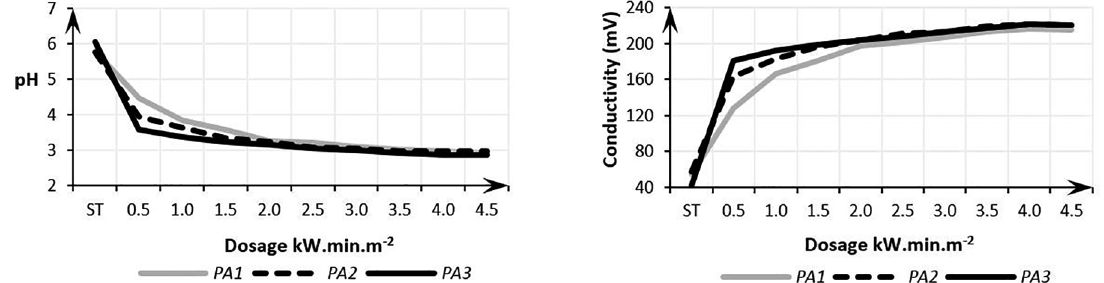
Figure 4. Conductivity and pH of aqueous extraction of the polyamide fabrics before and after plasma treatment.